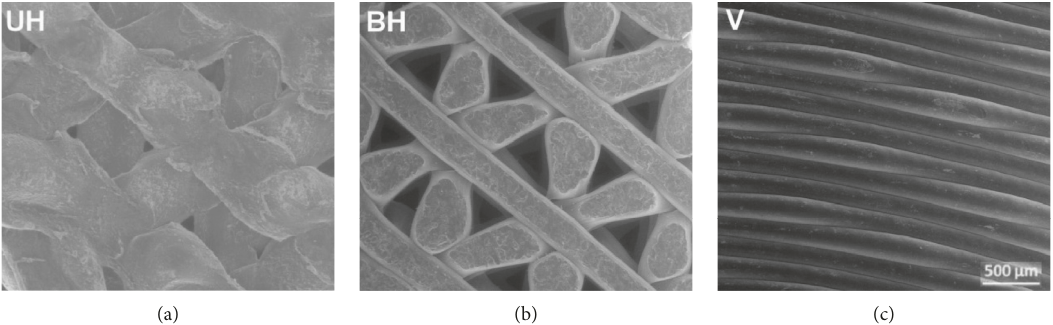
Figure 6: SEM micrographs of upper (UH) and underside (BH) layers of samples surface obtained by 3D printing in horizontal (H) and vertical (V) directions (adapted with permission from ref.